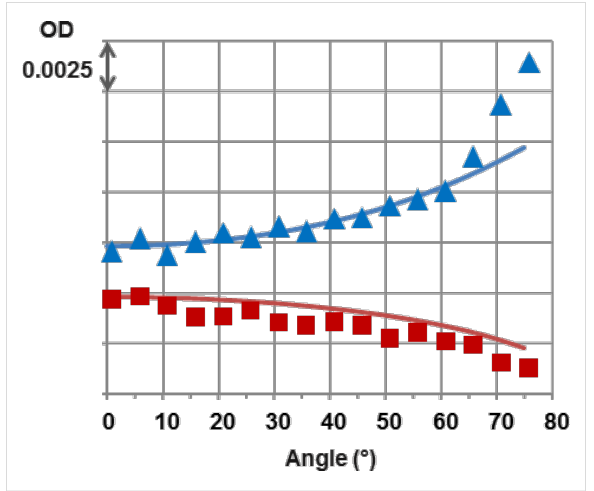
Figure 4: Optical signature of orientations of self-organized PTCDI- C13. Variable-incidence polarized-transmission analysis of the contri- bution of the self-assembled molecular monolayer to the absorption (blue triangle: TE, red squares: TM). The optical density at the absorp- tion maximum ( λ = 561 nm), as obtained from a fit of the absorption line of the molecule, is plotted. The continuous lines represent the TE and TM theoretical absorption variations [37] considering molecular transition dipole moments lying flat on graphene. For randomly- oriented transition dipole moments, both TE and TM should increase with incidence following the blue